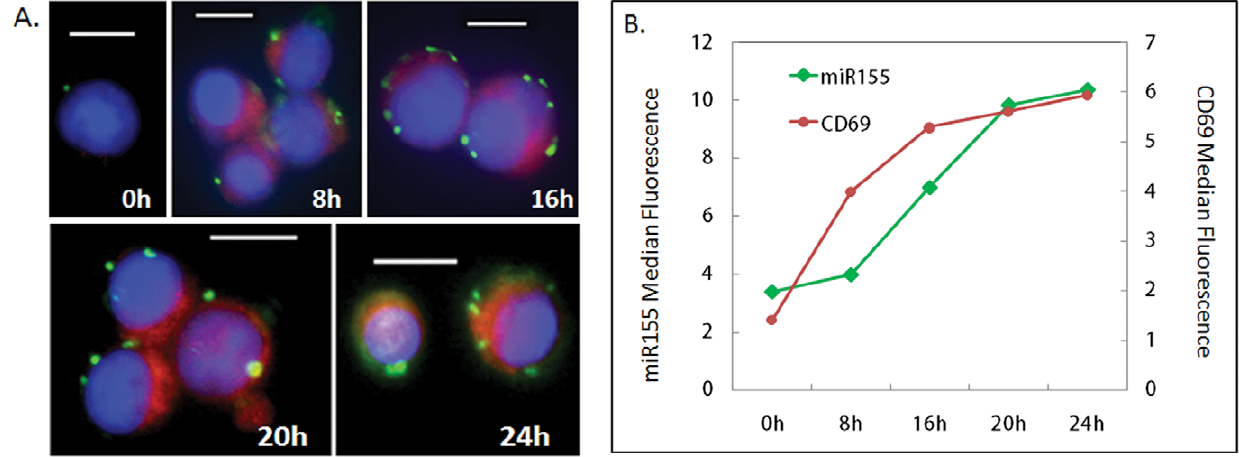
Figure 3. Multiplexed detection of CD69 and miR155 using imaging and flow-FISH. A. Images of Jurkat cells showing RCA amplified miR155 signal as green dots in the cytosol, CD69 proteins stained with Qdot705 as red, and the nucleus is in blue. B. Median values of multiplexed miR155 fluorescence and CD69-Qdot705 fluorescence collected via flow cytometry.